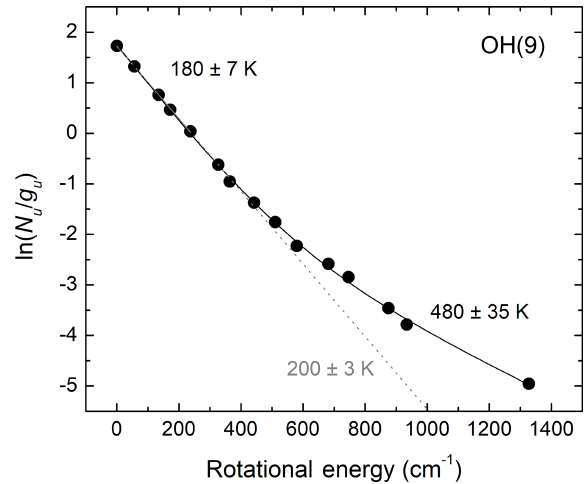
Figure 4. Mesospheric OH( v = 9) rotational population distribu- tion based on the observations of Noll et al. (2018; Fig. 3b). The grey dotted line shows the result of a single-temperature fit for E < 250cm − 1 . The black solid line shows a two-temperature fit us- ing all the data points. Not considering the bimodality of the rota- tional population results in large systematic errors because the con- tributions of the non-thermalized Boltzmann distribution to the low rotational energy region are not accounted